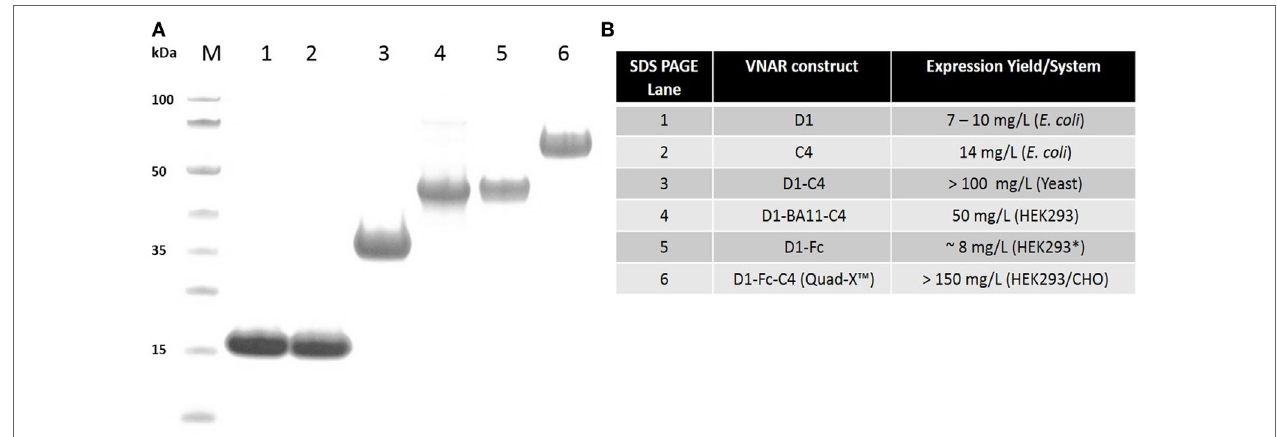
FigUre 1 | SDS PAGE and protein expression yield analysis of variable new antigen receptor (VNAR) constructs. (a) SDS PAGE and Coomassie blue staining of 5 µg of dithiothreitol-treated VNAR constructs. M, molecular weight marker. (B) Protein expression yield in specified expression systems. All expression